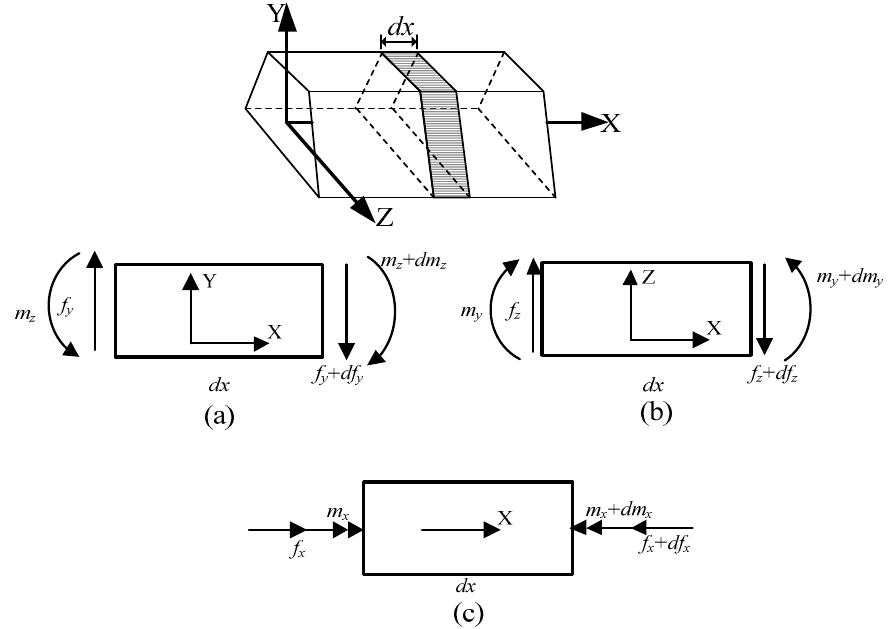
Figure 3. The equilibrium diagrams of forces and moments for an infinitesimal beam segment in the xy- ( a ) and xz-planes ( b ) and the x-direction ( c ). The mass moments of inertia J x , J y and J z can be obtained by converting the area mo-